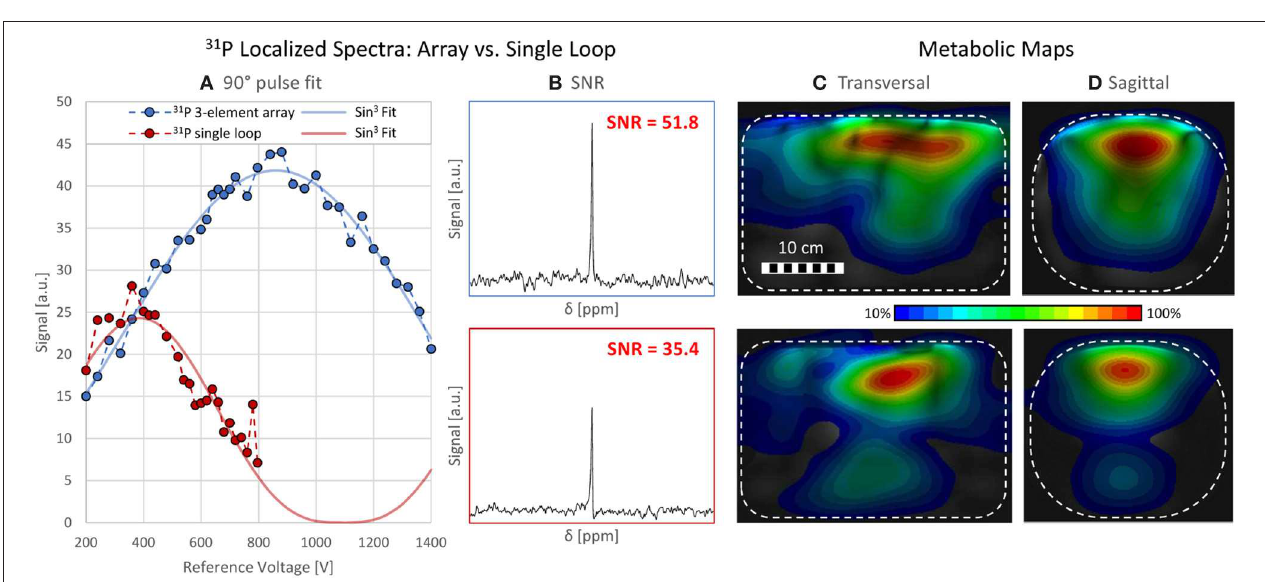
FIGURE 6 | Localized Spectroscopy and CSI data. (A) shows all data points acquired with a STEAM sequence from a voxel of size 50 20 50 mm 3 7cm within a × × torso phantom containing 31 P. The blue and red data points represent the spectra acquired with the array and the loop, respectively. The course of the signal amplitude is fitted with a sin 3 function corresponding to the signal equation for STEAM sequences. The reference voltages are 400V (single loop) and 880V (array). (B) SNR comparison of localized spectra for array (SNR 51.8, top) and the loop (SNR 35.4, bottom). (C,D) Metabolic maps, interpolated from CSI data, scaled to = = their individual maximum, in a (C) transversal and (D) sagittal slice for the array (top) and the single loop (bottom). The phantom is depicted as a white rectangle.